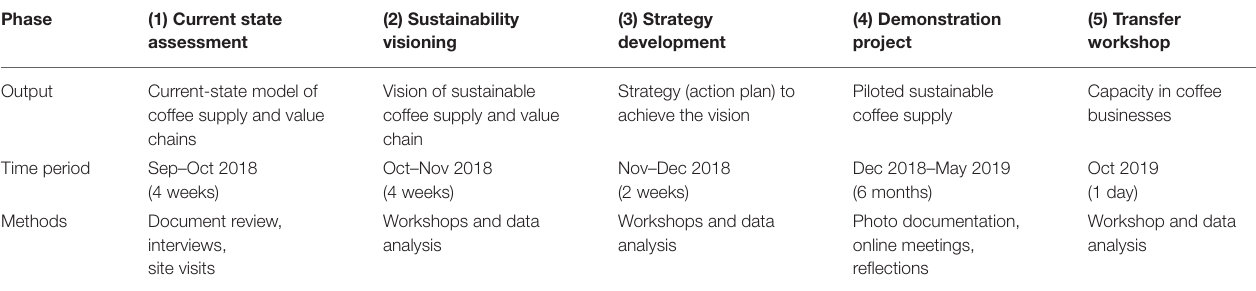
TABLE 1 | Phases of the project.